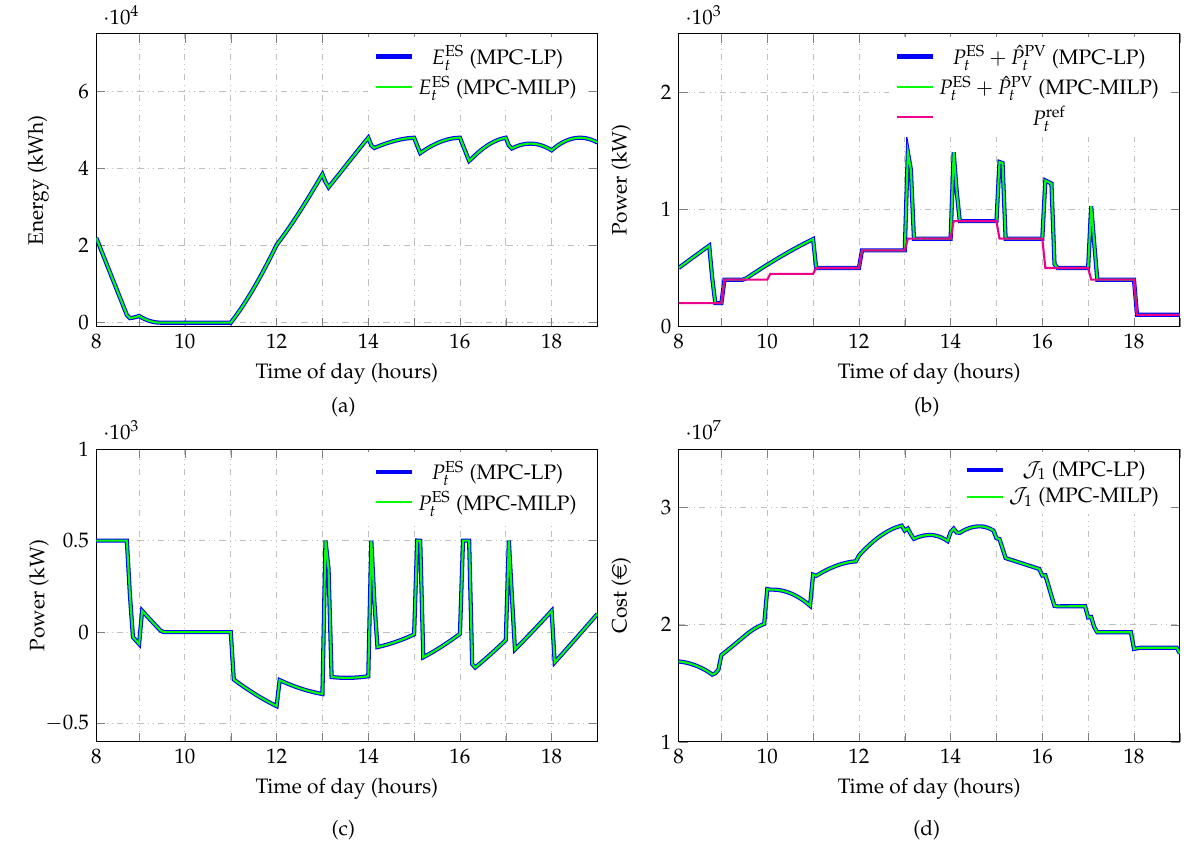
Figure 3. ( a ) Exchange power with the BESS; ( b ) cost of the optimization algorithm; ( c ) energy stored in batteries; and ( d ) power injected into the